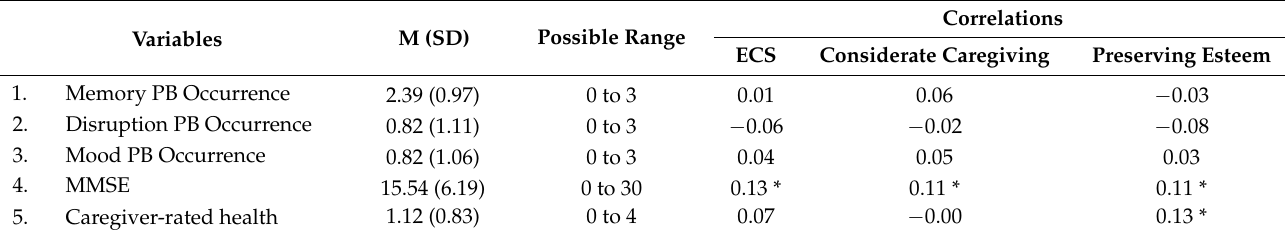
Table 3. Correlations of ECS and its subscales with CR variables.